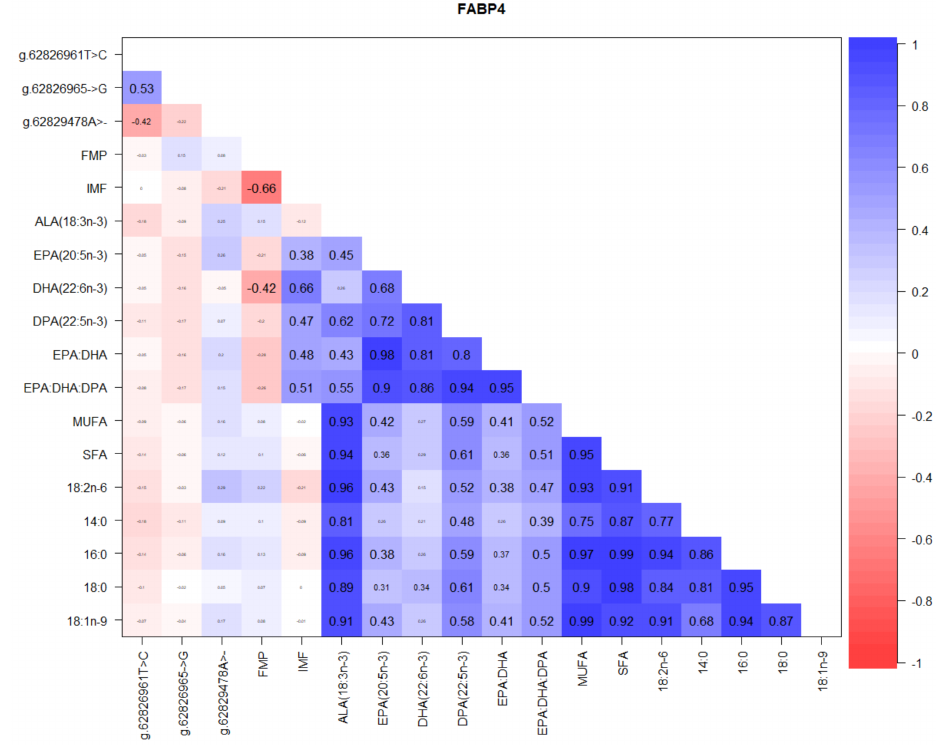
Figure 9. Correlations between FABP4 gene SNP loci, IMF, FMP, and fatty acids in TAW lambs.